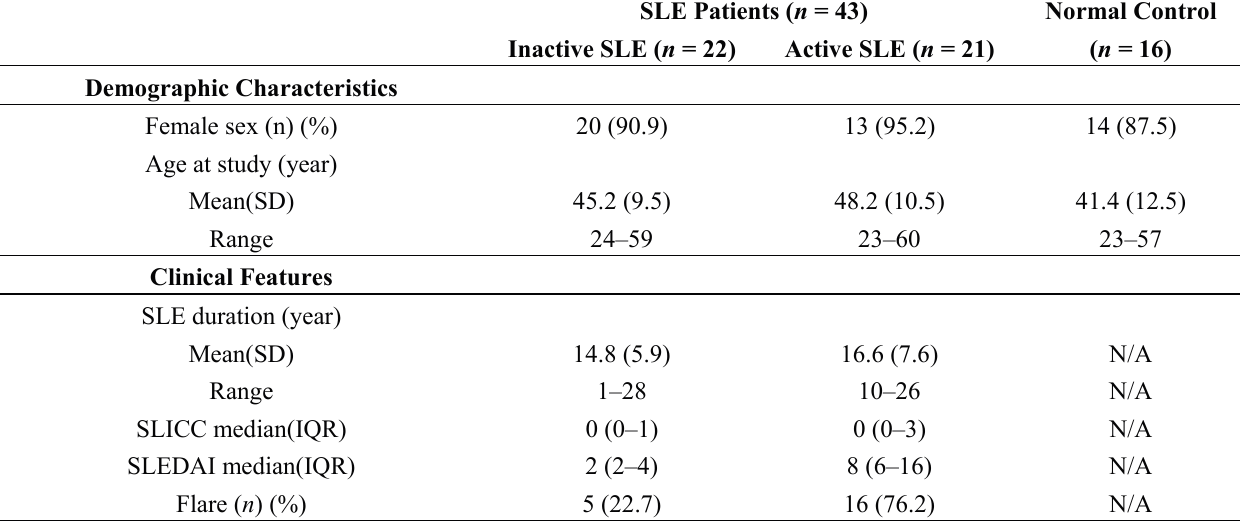
Table 1. Demographic and clinical characteristics of SLE patients and